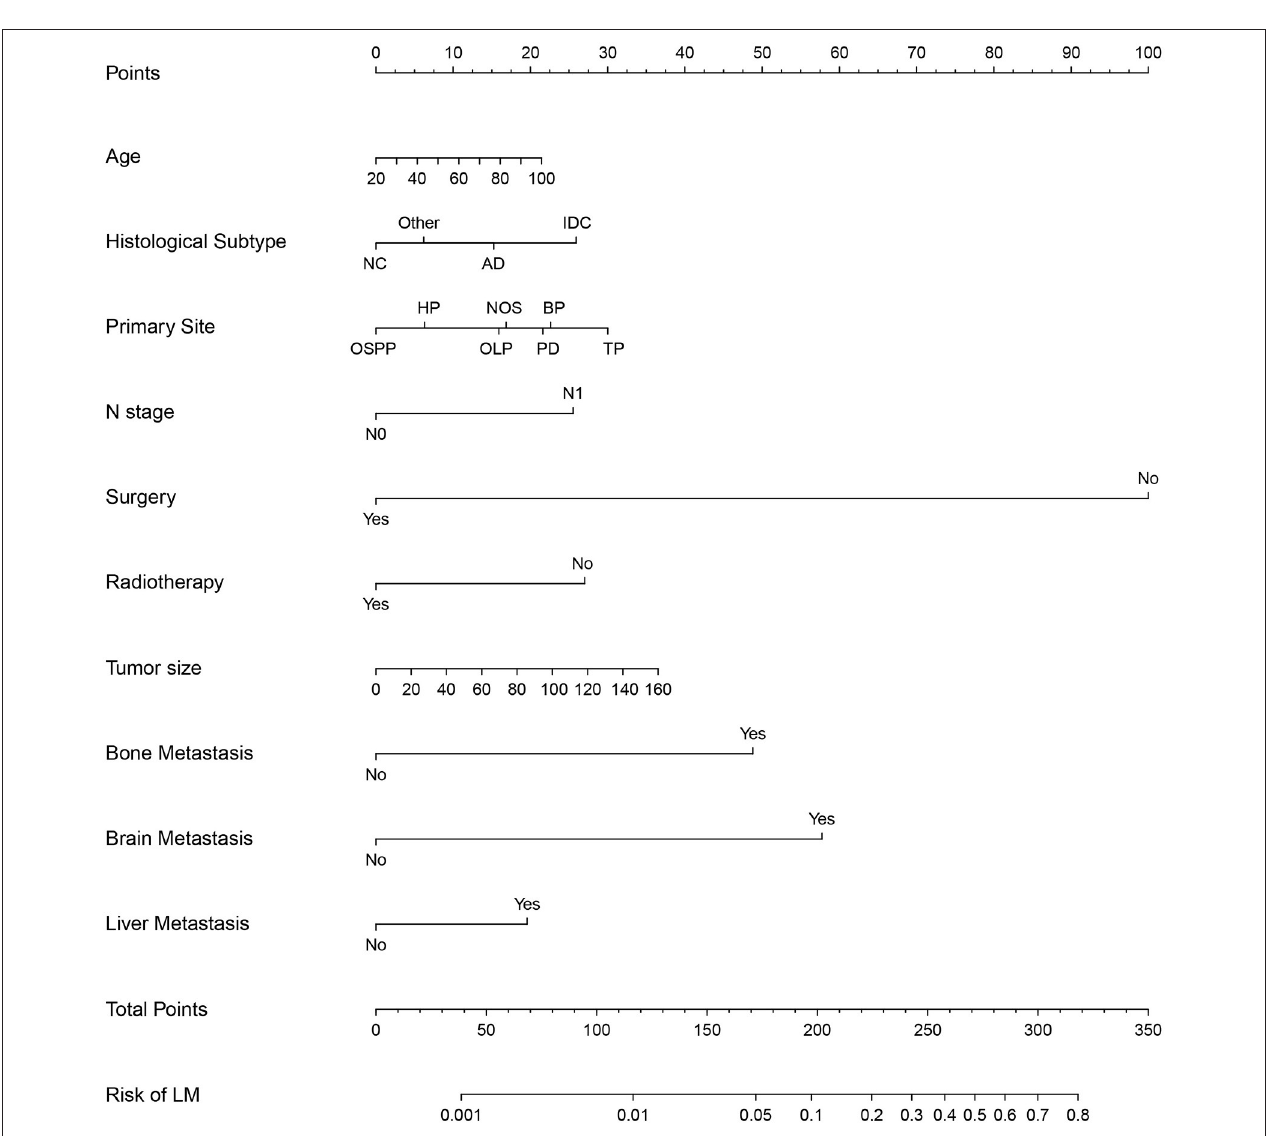
FIGURE 4 | Nomogram to estimate the risk factors of lung metastasis in patients with pancreatic cancer. HP, head of pancreas; BP, body of pancreas; OLP, overlapping lesion of pancreas; OSPP, other specified parts of pancreas; TP, tail of pancreas; PD, pancreatic duct; AC, Adenocarcinoma; IDC, Infiltrating duct carcinoma; NC, neuroendocrine